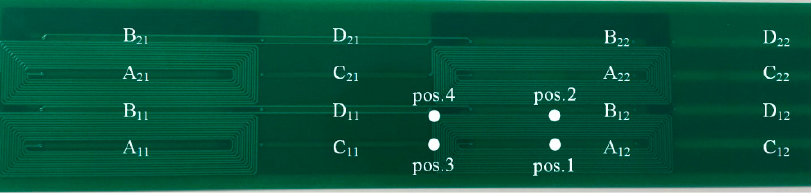
Figure 22. The PCB of the four ‐ layer rectangle layout detection coil array. Table 2. γ with the coin at different positions (pos.).